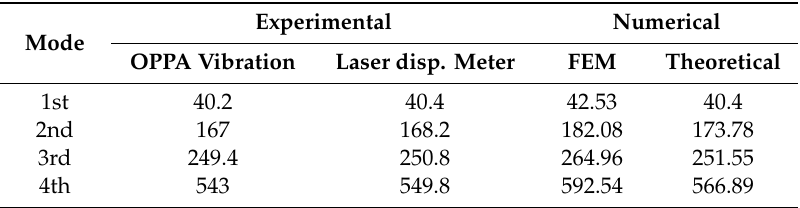
Figure 9. Vibration analysis system using OPPA 1 method. ( a ) Analysis system; ( b ) Specimen (Cantilever plate with heavy basement). Table 1. Comparison of resonance frequencies among OPPA method, laser displacement meter, finite element method and theoretical analysis. (Unit: